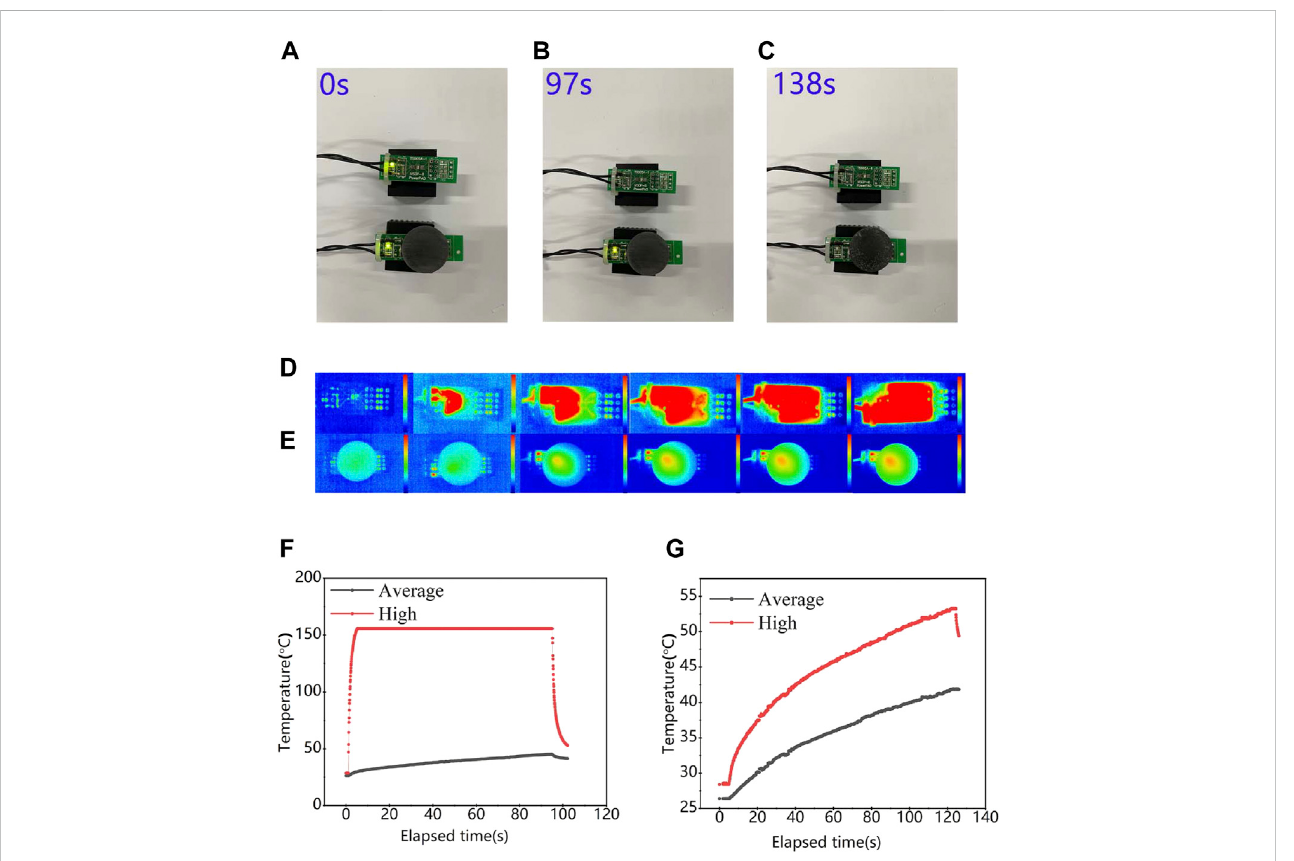
FIGURE 6 ComparisonofheatdissipationperformancewithandwithoutHP900inthechipresistor. (A – C) Opticalimagesoftheelectronicdevicewithandwithout HP900 as the heat dissipating material; (D,E) Corresponding infrared thermal images of working electronic devices with and without HP900 as the heat dissipating material; (F,G) maximum and average temperatures of two chip resistors as a function of their operation